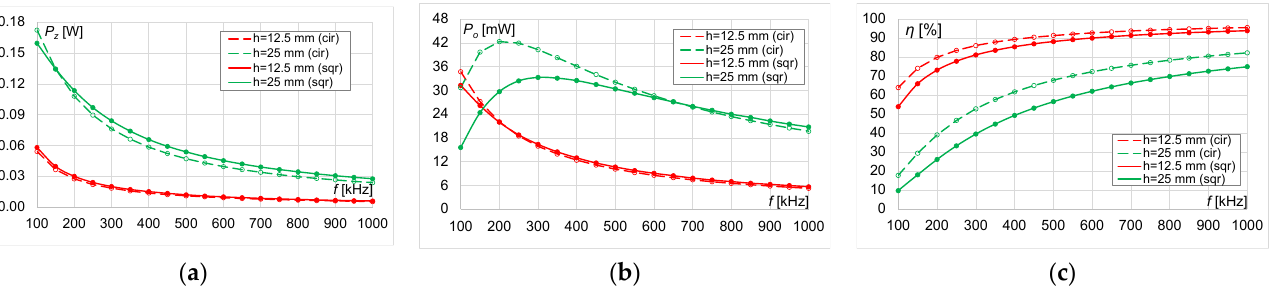
Figure 14. Results for circular and square coils with r = 25 mm and number of turns n = 60 at different distances ( h = 12.5 mm and h = 25 mm): ( a ) transmitter power, ( b ) receiver power and ( c ) power transfer efficiency.